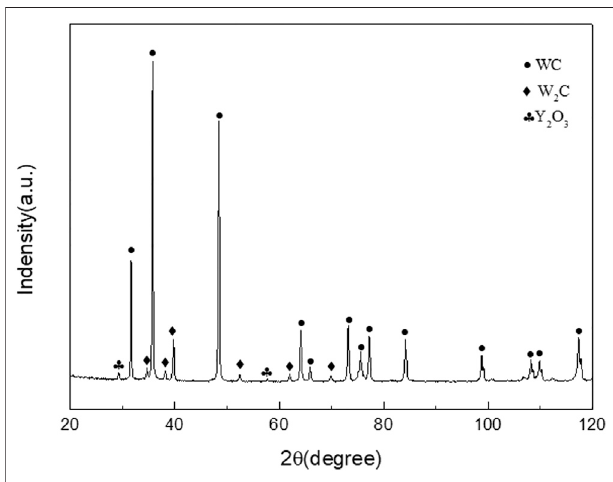
FIGURE 9 | XRD pattern of WC-4wt.% Y 2 O 3 .